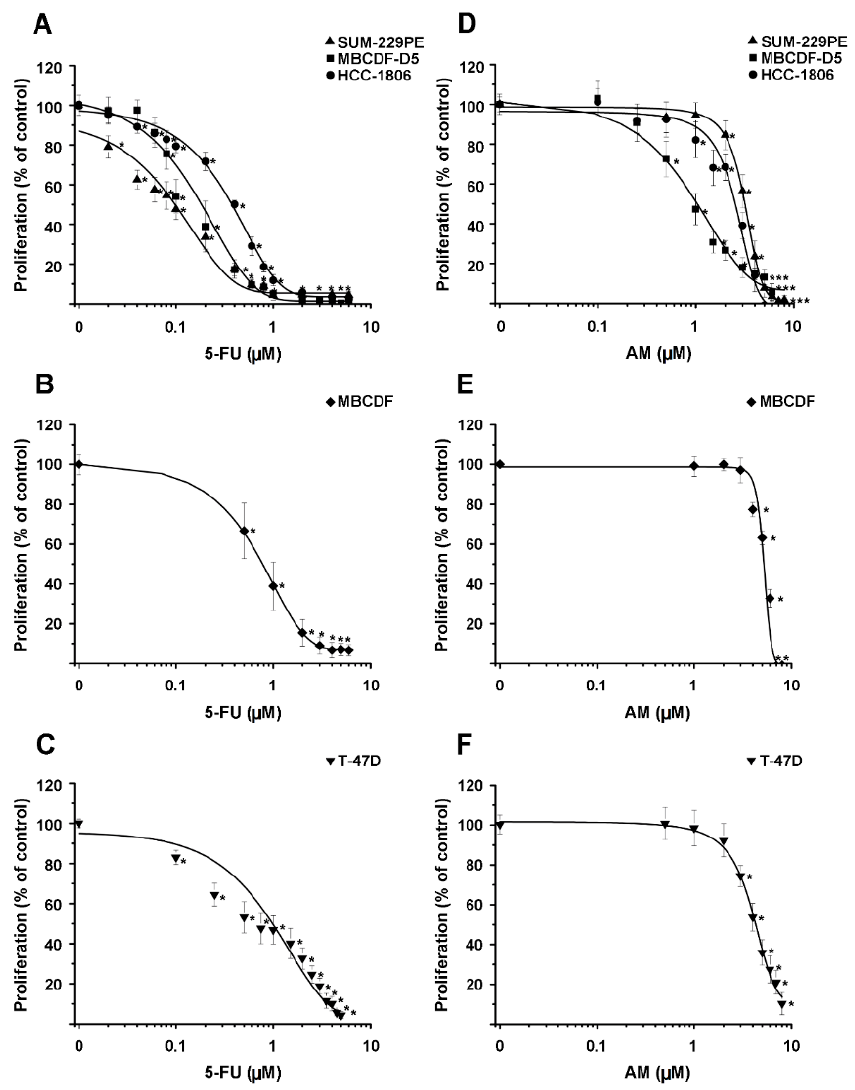
Figure 1. Antiproliferative effects of 5-fluorouracil and α -mangostin in a panel of breast cancer cells. The chemotherapeutic agent 5-fluorouracil (5-FU) and the xanthone α -mangostin (AM) dose-dependently inhibited cell proliferation with different potency, depending on the cell phe- notype: triple negative ( A , D ), HER-2 enriched ( B , E ) and ER+ ( C , F ). The results are depicted as the mean ± SEM of six replicates in at least three independent experiments. Data from vehicle-treated cells were normalized to 100%. * P ˂ 0.001 vs. control.